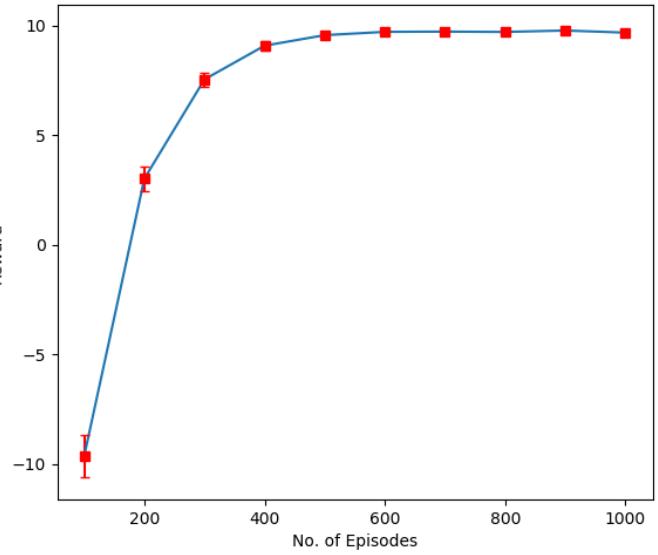
Figure 5. Sumrate performance of RL algorithm for 30 users, four receive antennas at BS and one transmit antenna at each